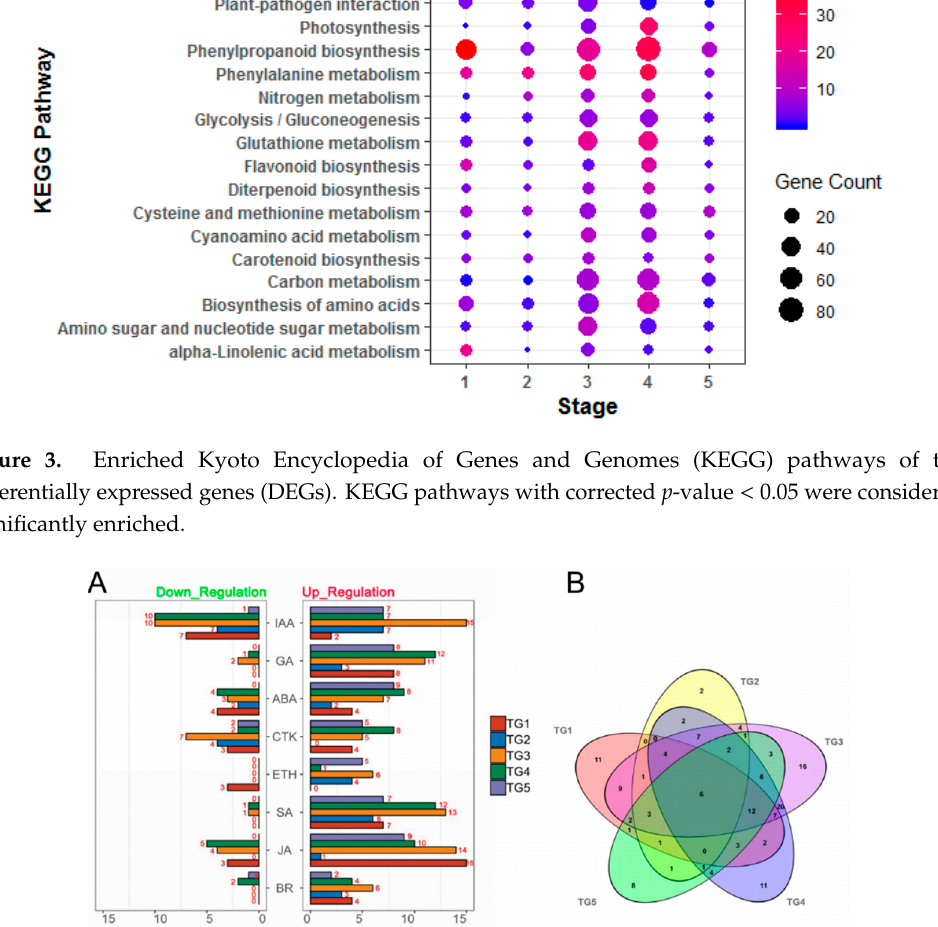
Figure 4. Statistics of hormone-associated genes at different stages of S. graminicola infection. ( A ) Numbers of hormone-associated DEGs at different stages (|Fold-change| ≥ 2). ( B ) Venn diagram showing the numbers of DEGs (|Fold-change| ≥ 2) at each stage with infection.